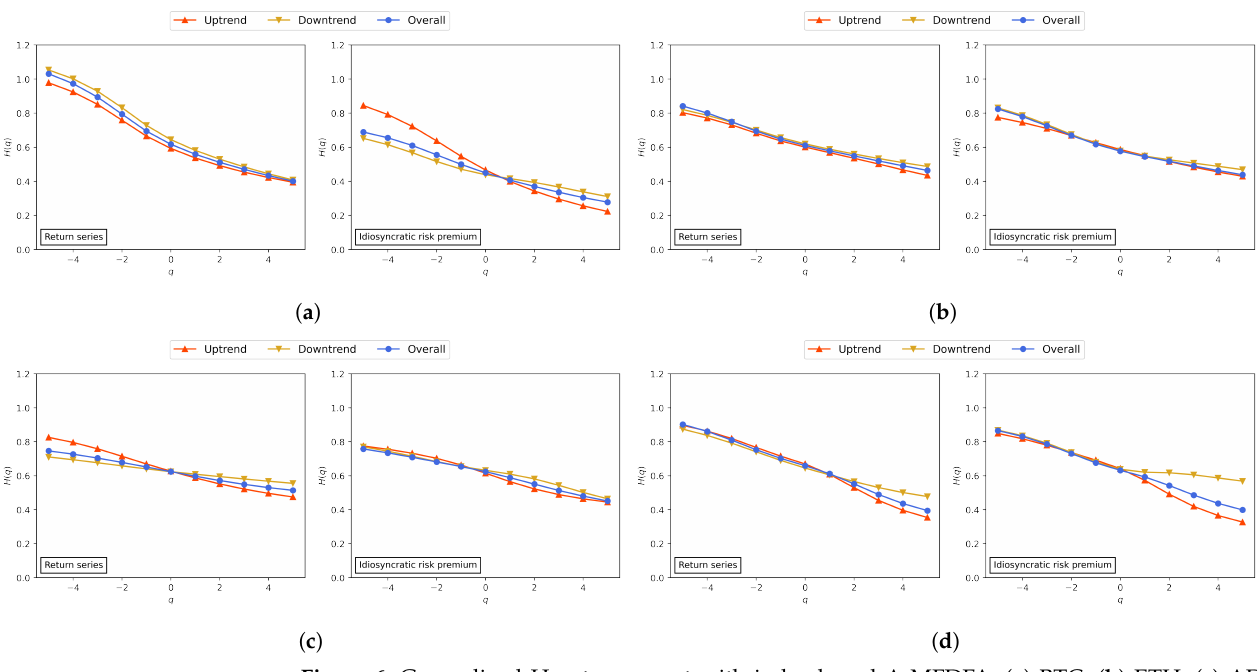
Figure 6. Generalized Hurst exponent with index-based A-MFDFA. ( a ) BTC. ( b ) ETH. ( c ) ADA. ( d )